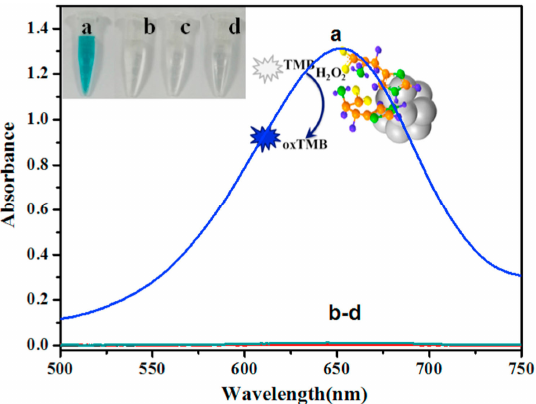
Figure 6. UV – visible absorption spectra of different system: ( a ) TMBHis ‐ AuNC ‐ H 2 O 2 , ( b )TMB ‐ H 2 O 2 , Figure 6. UV–visible absorption spectra of different system: ( a ) TMBHis-AuNC-H 2 O 2 , ( b )TMB-H 2 O 2 , ( c ) TMB ‐ His ‐ AuNC and ( d ) TMB ‐ His ‐ H 2 O 2 . Reprinted with permission from [44]. Copyright © 2017 ( c ) TMB-His-AuNC and ( d ) TMB-His-H 2 O 2 . Reprinted with permission from [44]. Copyright © 2017 Elsevier. Elsevier.